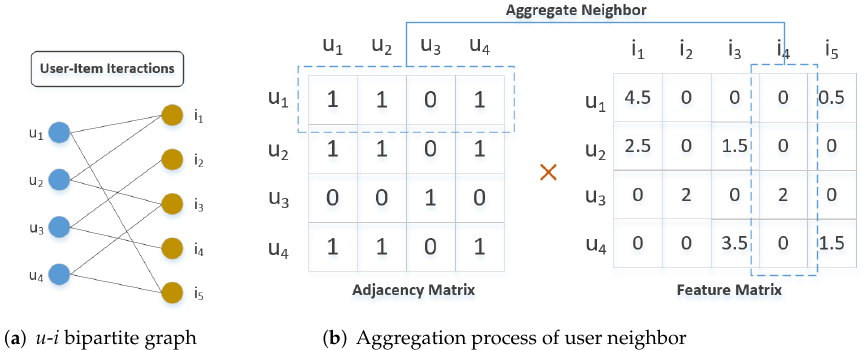
Figure 4. Generating user adjacency matrix from user–item bipartite